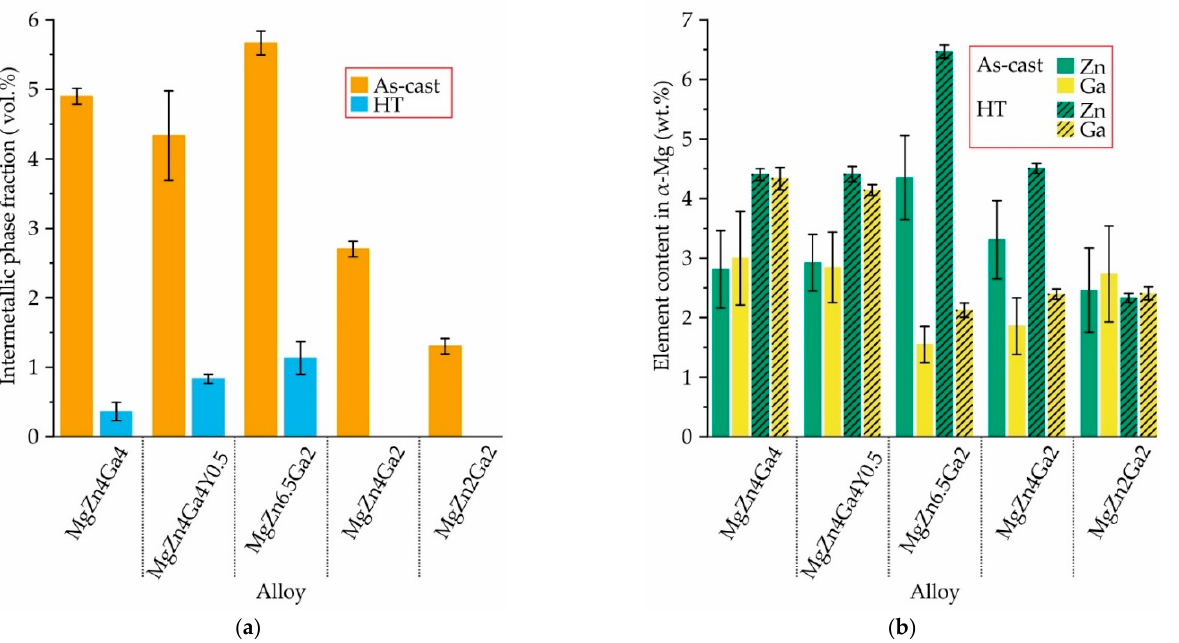
Figure 5. ( a ) Total fraction of intermetallic phases Mg 51 Zn 20 (or Mg 12 Zn 13 after HT), Mg 5 Ga 2 , and Ga– Y, and ( b ) content of Zn and Ga in the α -Mg solid solution for Mg–Zn–Ga–(Y) alloys in as-cast and HT